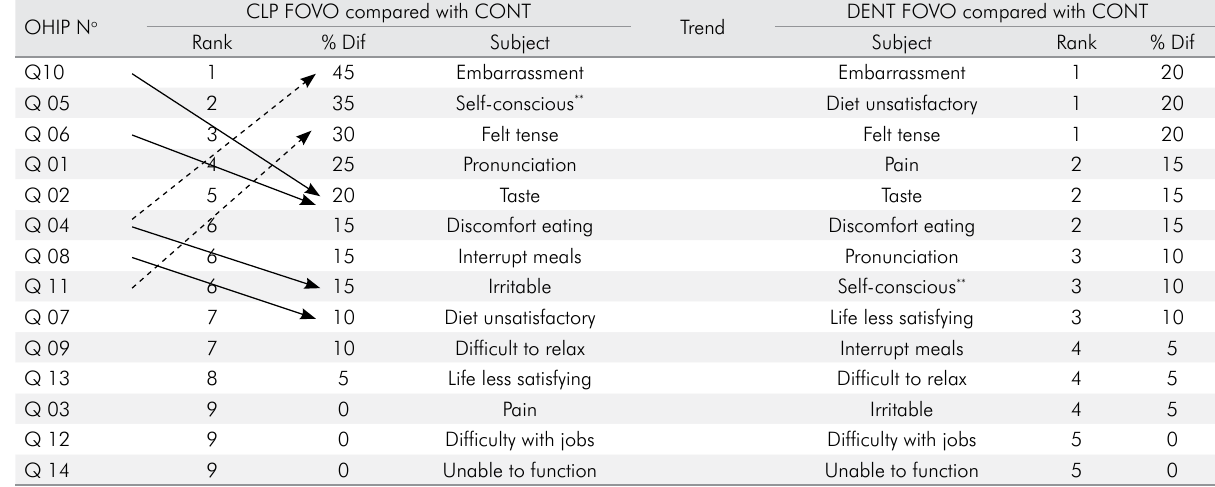
Table 3. Ranking of OHIP-14 items in a descending order by score in prevalence between CLP, DENT and